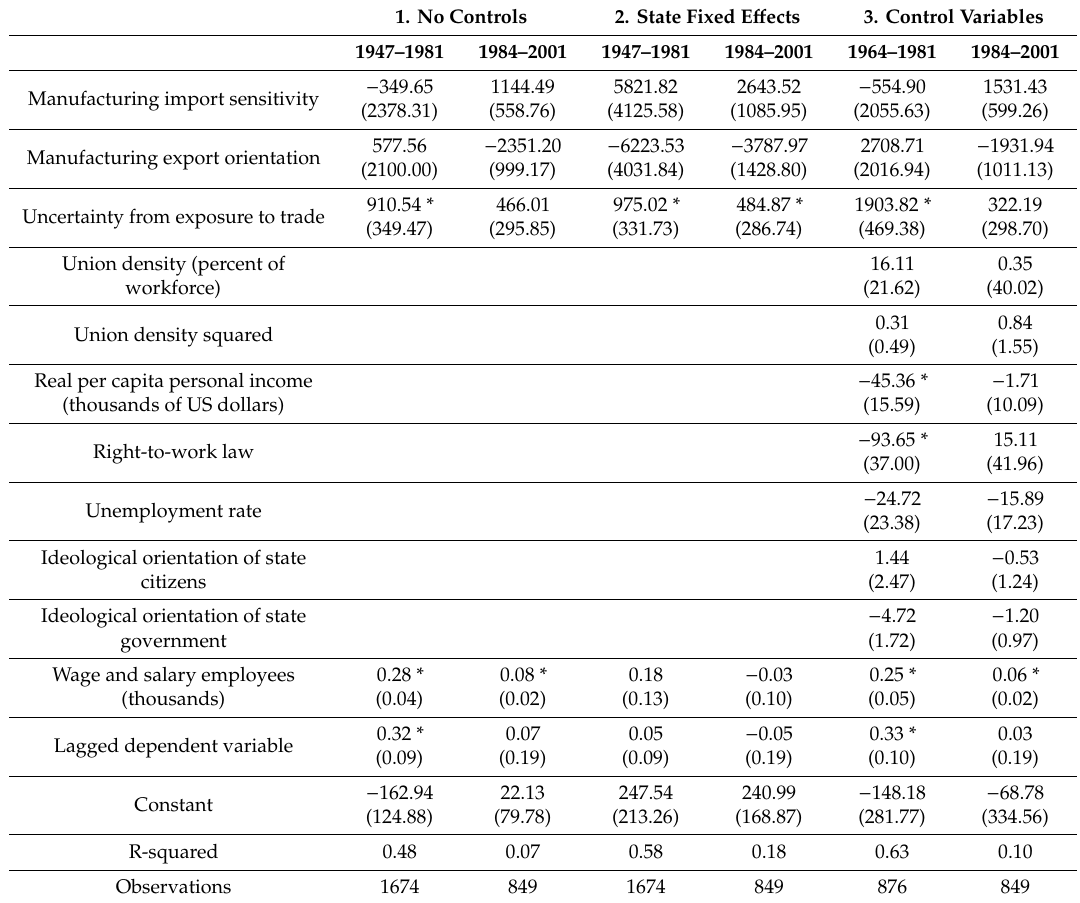
Table 2. Ordinary least squares (OLS) Models of Person-Days Lost to Work Stoppages in U.S. States. 1. No